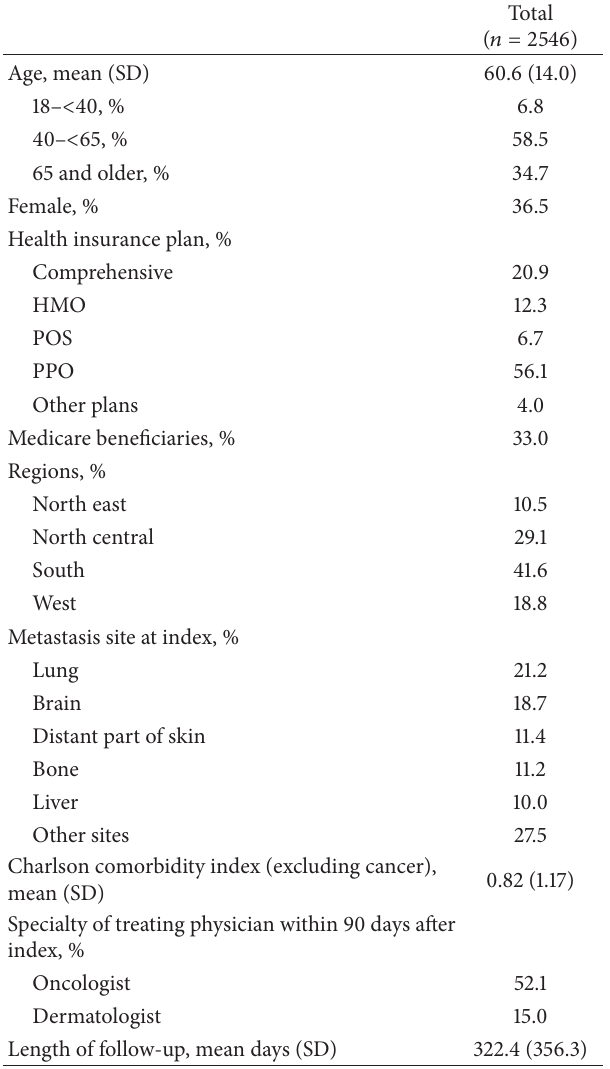
Table 1: Patient demographic and clinical characteristics.